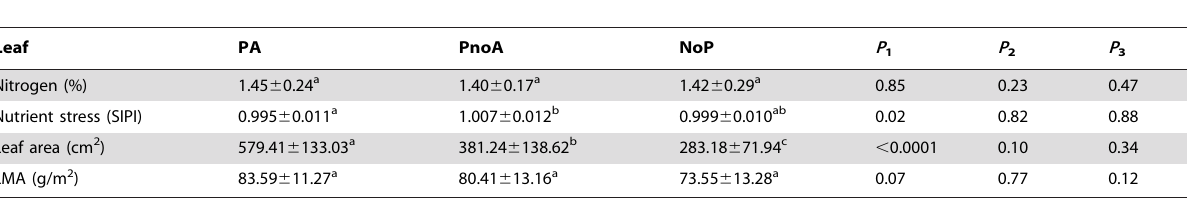
Table 4. Effect of symbiont association and pitcher presence on leaf quality.